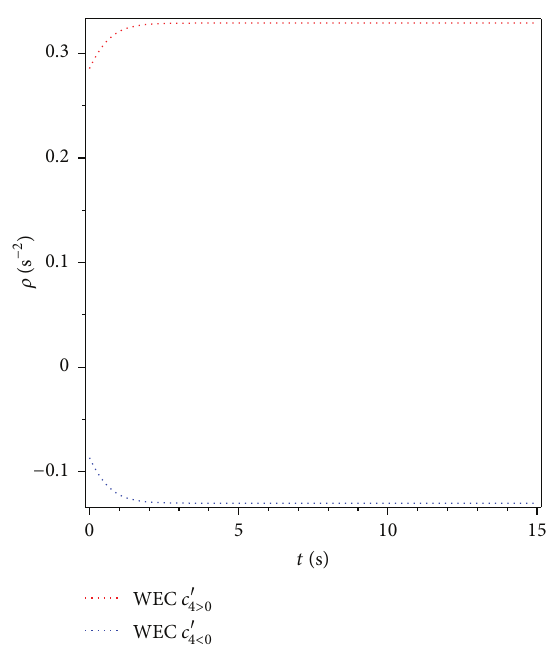
Figure 3: The evolution of the WEC for closed model. Here the sign of the three constants 𝑐 󸀠 1 , 𝑐 󸀠 2 , and 𝑐 󸀠 3 has no effect on the evolution of WEC; however, 𝑐 󸀠 4 must have positive value to satisfy the WEC.